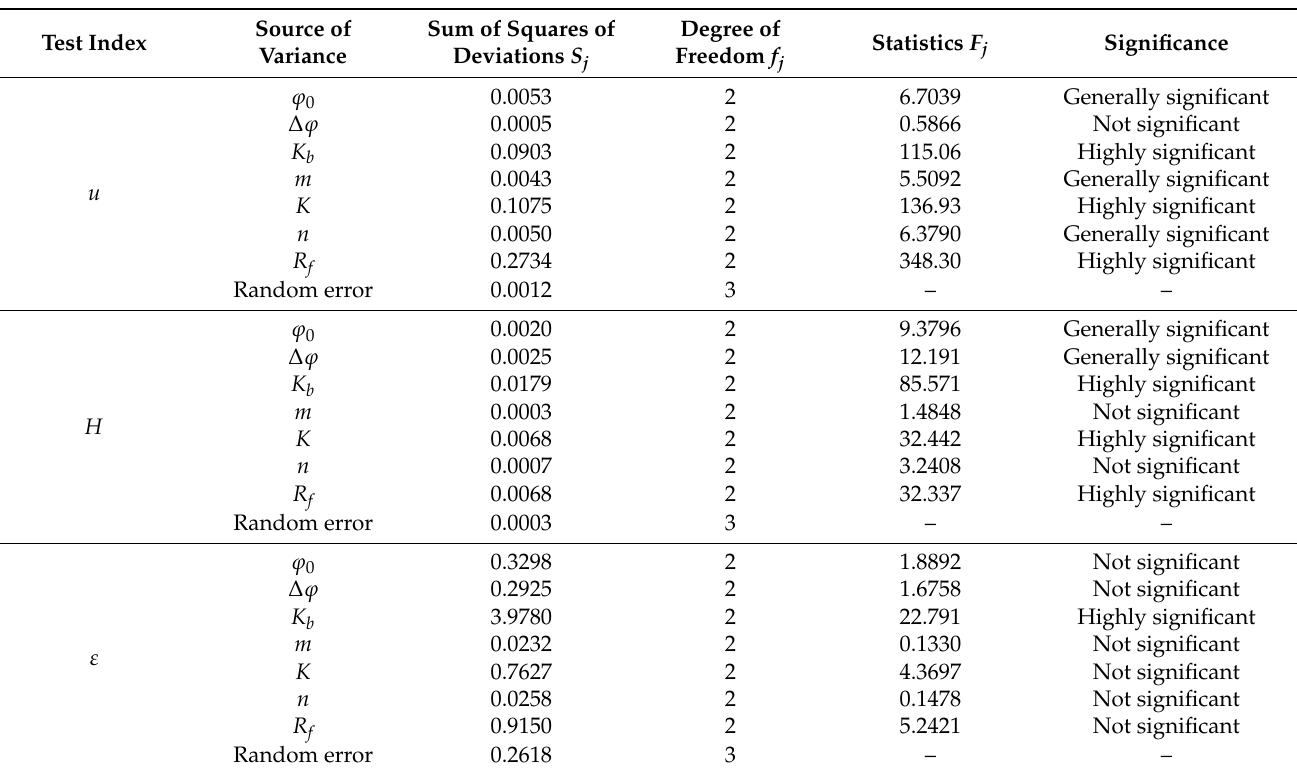
Table 13. ANOVA results of influencing factors of each test index for the reservoir bottom back- fill